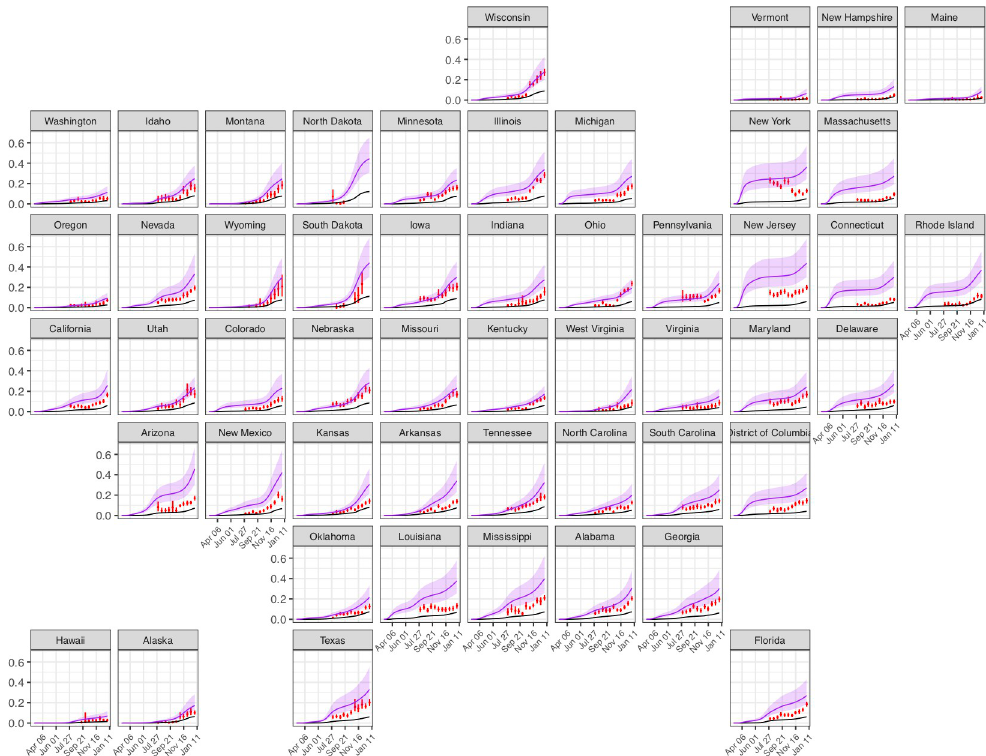
Fig 7. Comparison of the estimated percent ever-infected with SARS-CoV-2 (purple line, shaded areas represent 95% credible intervals) to CDC seroprevalence estimates from commercial laboratory data (red vertical line) and cumulative reported cases (black line) for each US state from March 1, 2020 to January 1,